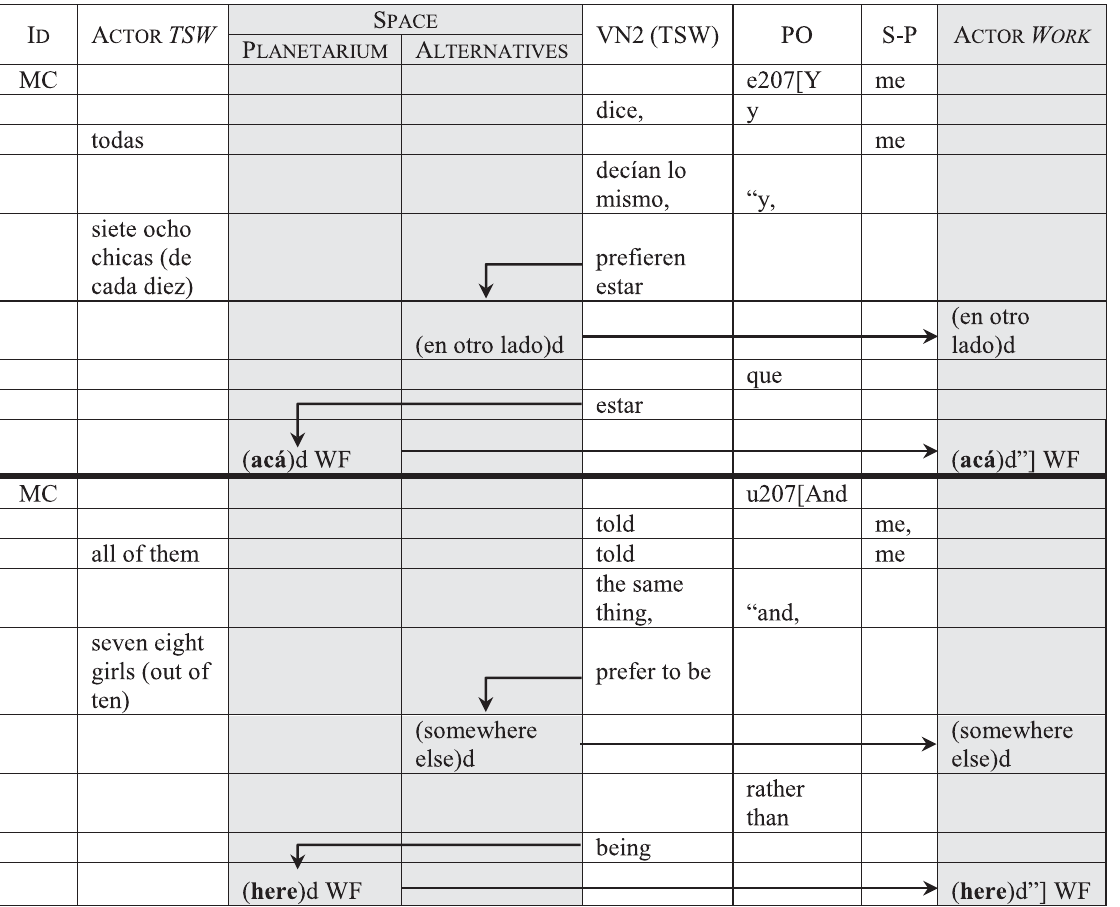
TABLE 7 | Discursive identi fi cation of the Space and Actor Work